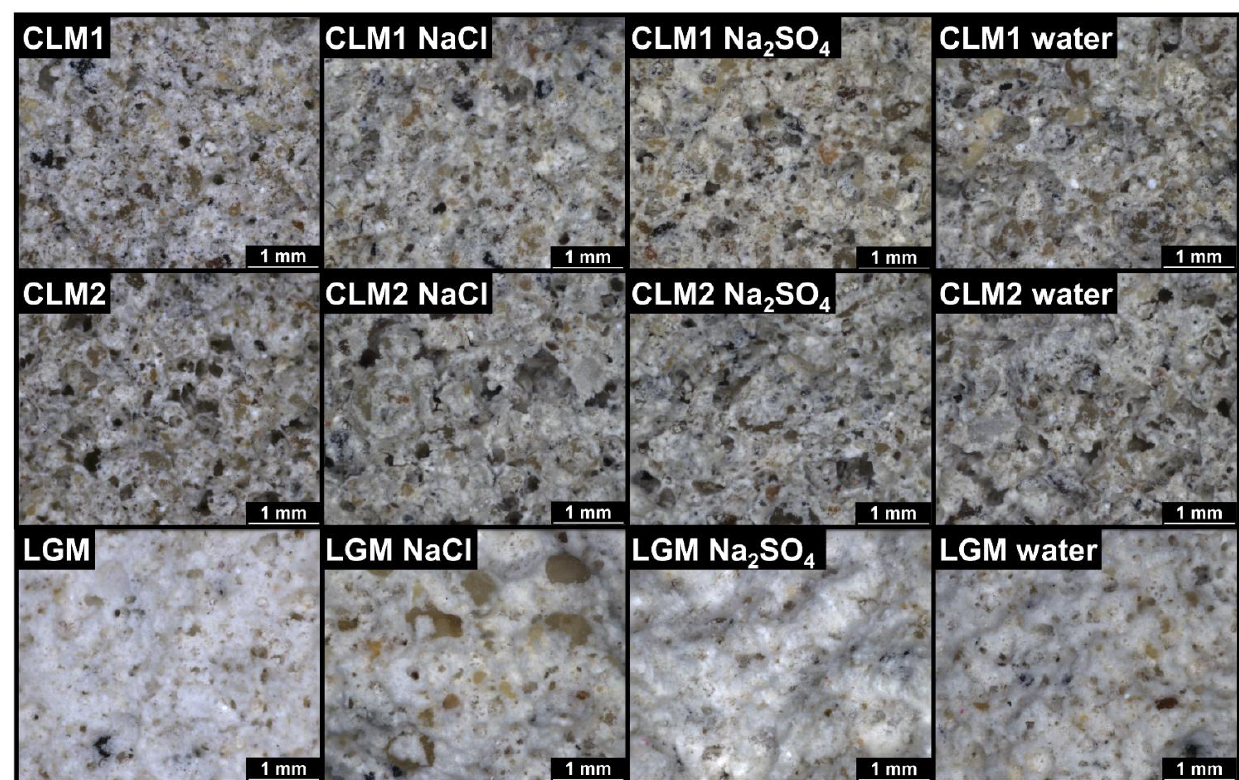
Figure 4. Structure of the hardened plasters analyzed by light microscopy.